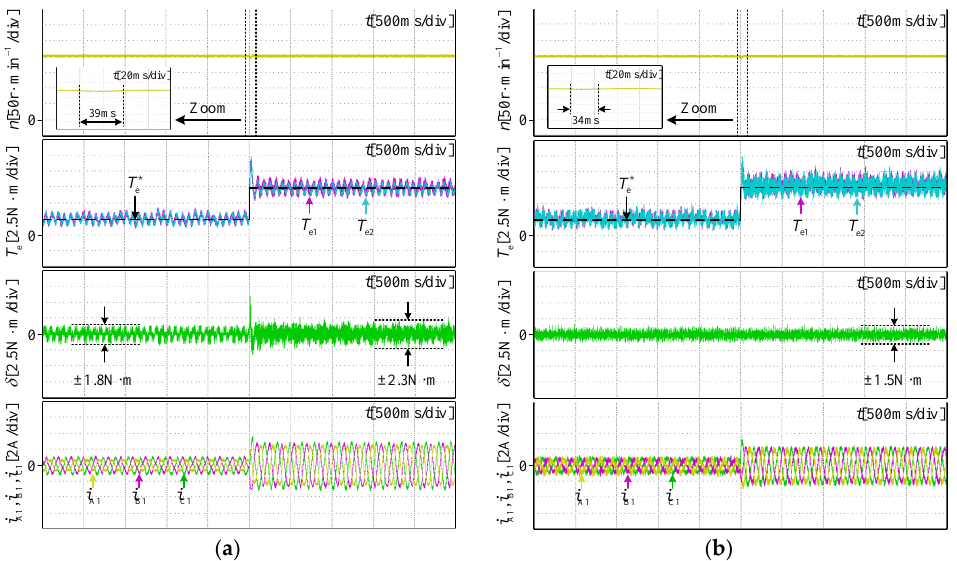
Figure 15. Waveforms for step change of load torque: ( a ) the closed-loop control strategy and ( b ) the proposed FCS-MPC strategy.